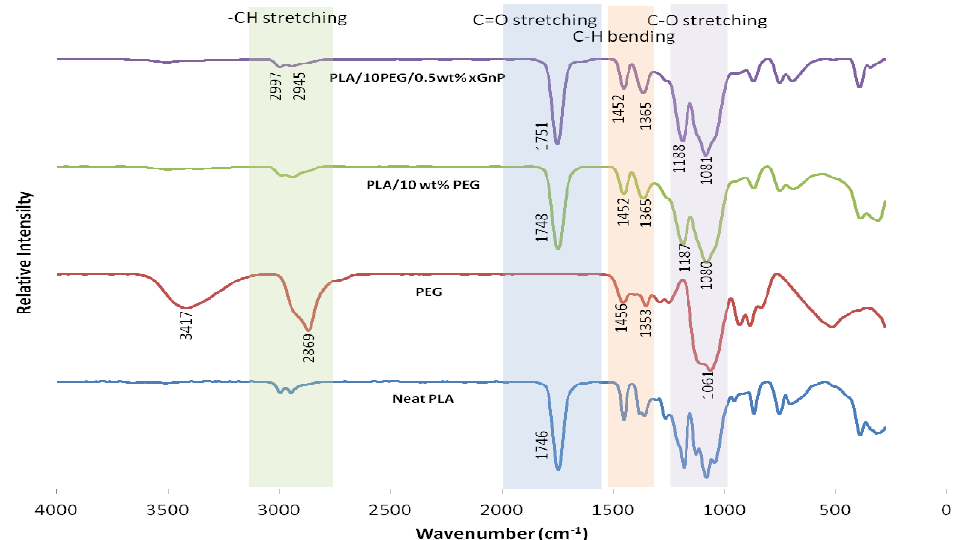
Figure 3. Fourier transform infrared (FTIR) spectra of PLA, PEG, PLA/PEG blend and PLA/PEG/xGnP